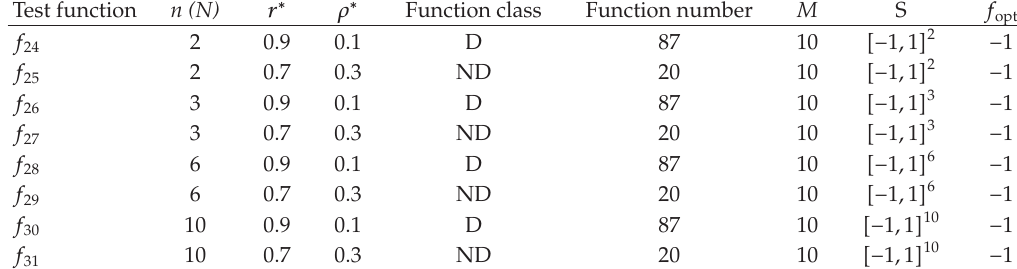
Table 16: Used GKLSfunctions.